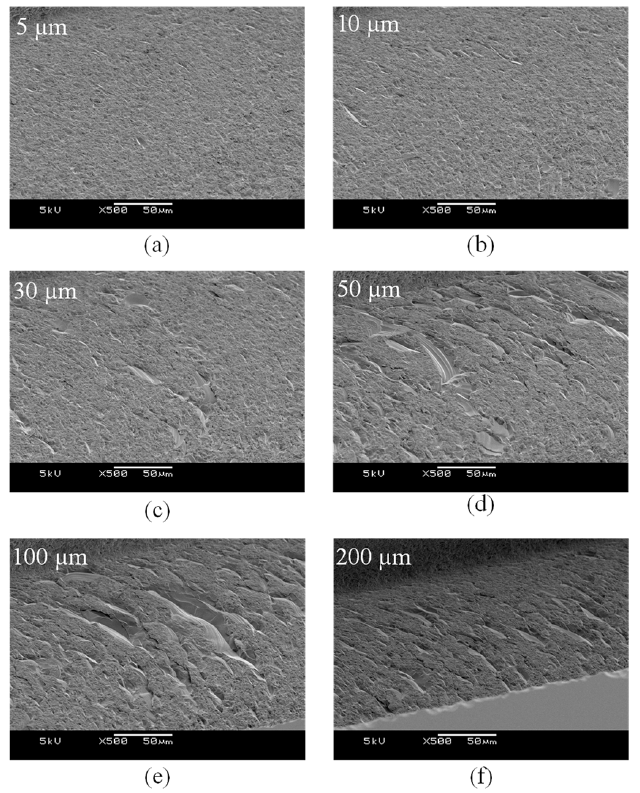
Figure 6. SEM images of the channels with different depths of cut ( a ) 5 µm, ( b ) 10 µm, ( c ) 30 µm,